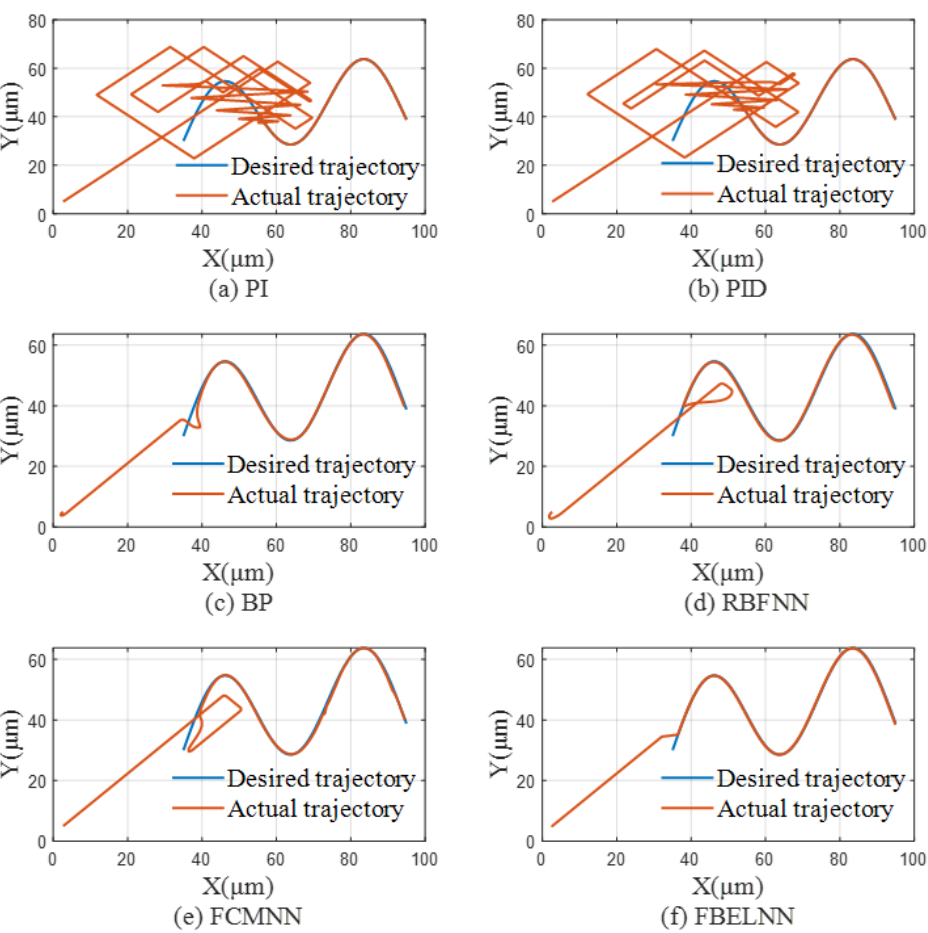
Figure 7. The comparison of single-cell trajectory using each controller: ( a ) Use PI as a controller. ( b ) Use PID as a controller. ( c ) Use BP as a controller. ( d ) Use RBFNN as a controller. ( e ) Use FCMNN as a controller. ( f ) Use FBELNN as a controller.